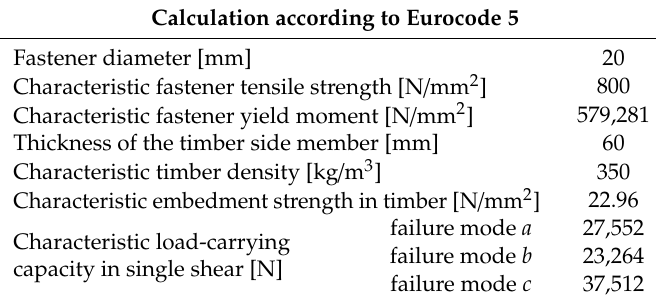
Table 3. Calculation of characteristic load-carrying capacity according to Eurocode